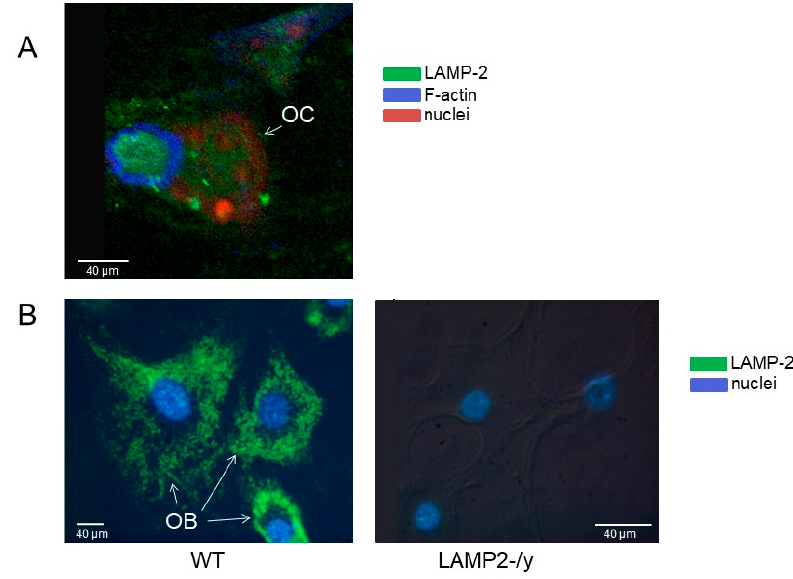
Figure 1. Lysosome associated membrane protein 2 (LAMP-2) localization in osteoclast and osteoblasts. LAMP-2 (visualized with alexa-488 (green), localization in ( A ) Confocal image of a wild type osteoclast (OC) on a cortical bone slice. The green LAMP-2 label is mainly present in the area surrounded by actin (visualized with phalloidin-alexa-633, in blue). This area is considered as the ru ffl ed border area. Nuclei were stained with propidium iodide (red). ( B ) Wild-type (left) and LAMP-2- / y (right) osteoblasts (OB) cultured on plastic. Images made by a converted fluorescence microscope. The green LAMP-2 label is present throughout the cytoplasm of wild type cells, but completely absent in the LAMP-2- / y cells. Nuclei were stained with di-amidino-2-phenylindole-dihydrochloride